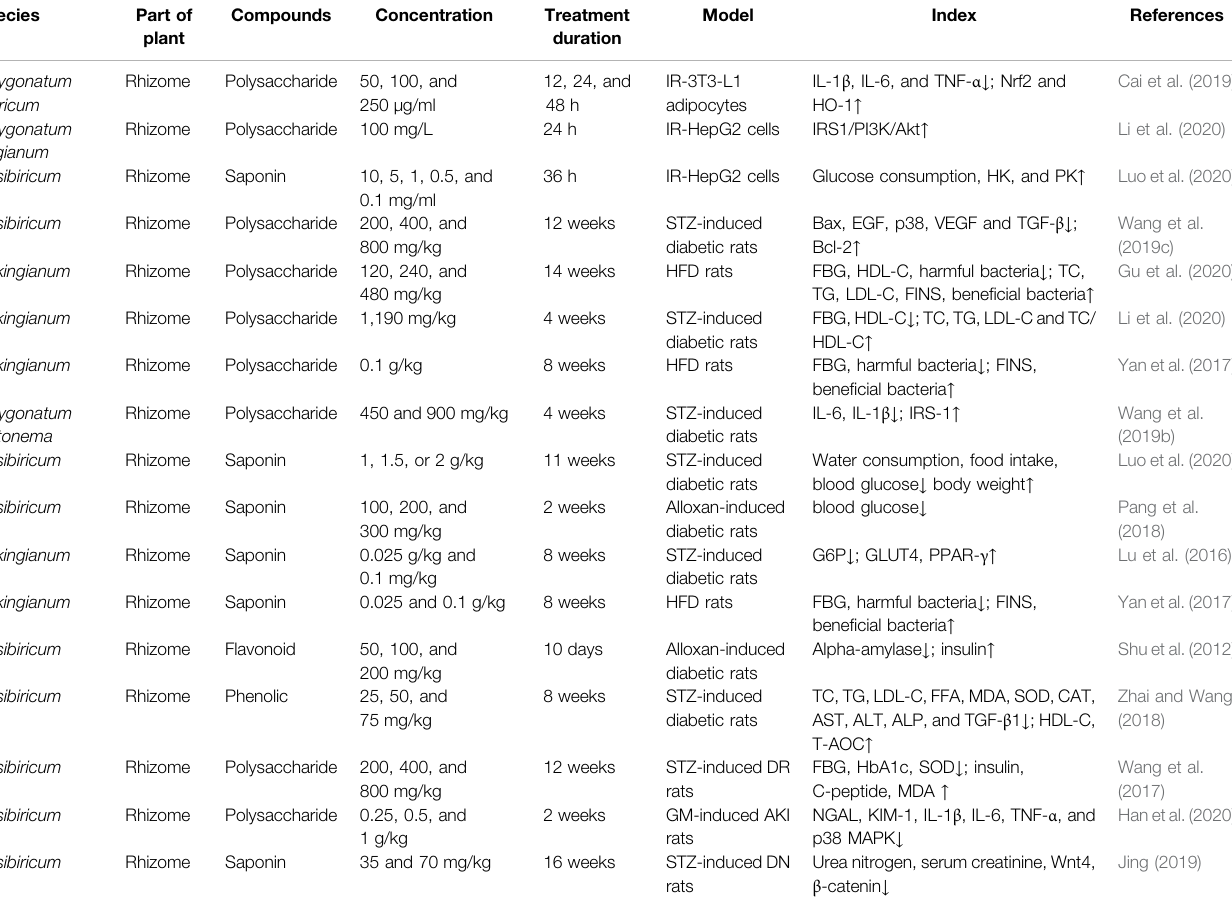
TABLE 3 | Antidiabetic properties of three Polygonatum spp. in cells and animal models. Species